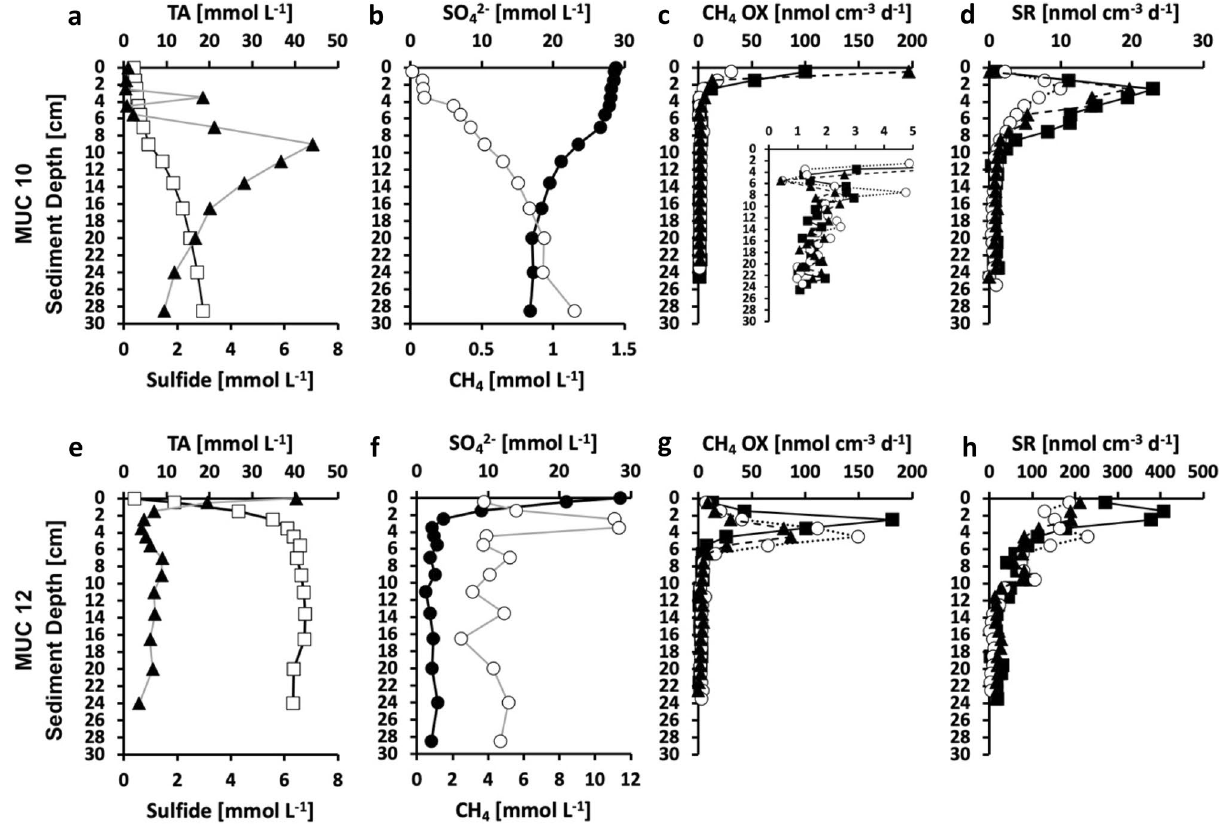
Figure 2. Biogeochemical data of sediment from MUC 10 ( Siboglinidae field , a – d ) and MUC 12 (bacterial mat field, e – h ). ( a , e ) Concentrations of pore-water total alkalinity (TA, open squares), and sulfide (solid triangles). ( b , f ) Concentrations of pore-water sulfate (SO 4 2− , solid circles) and sediment methane (CH 4 , open circles). Note the different x-axes for methane. ( c , g ) Methane oxidation rates (CH 4 OX, symbols represent three replicates). Note that c includes an insert that focusses on rates < 5 nmol cm −3 d −1 . ( d , h ) Sulfate reduction rates (SR, symbols represent three